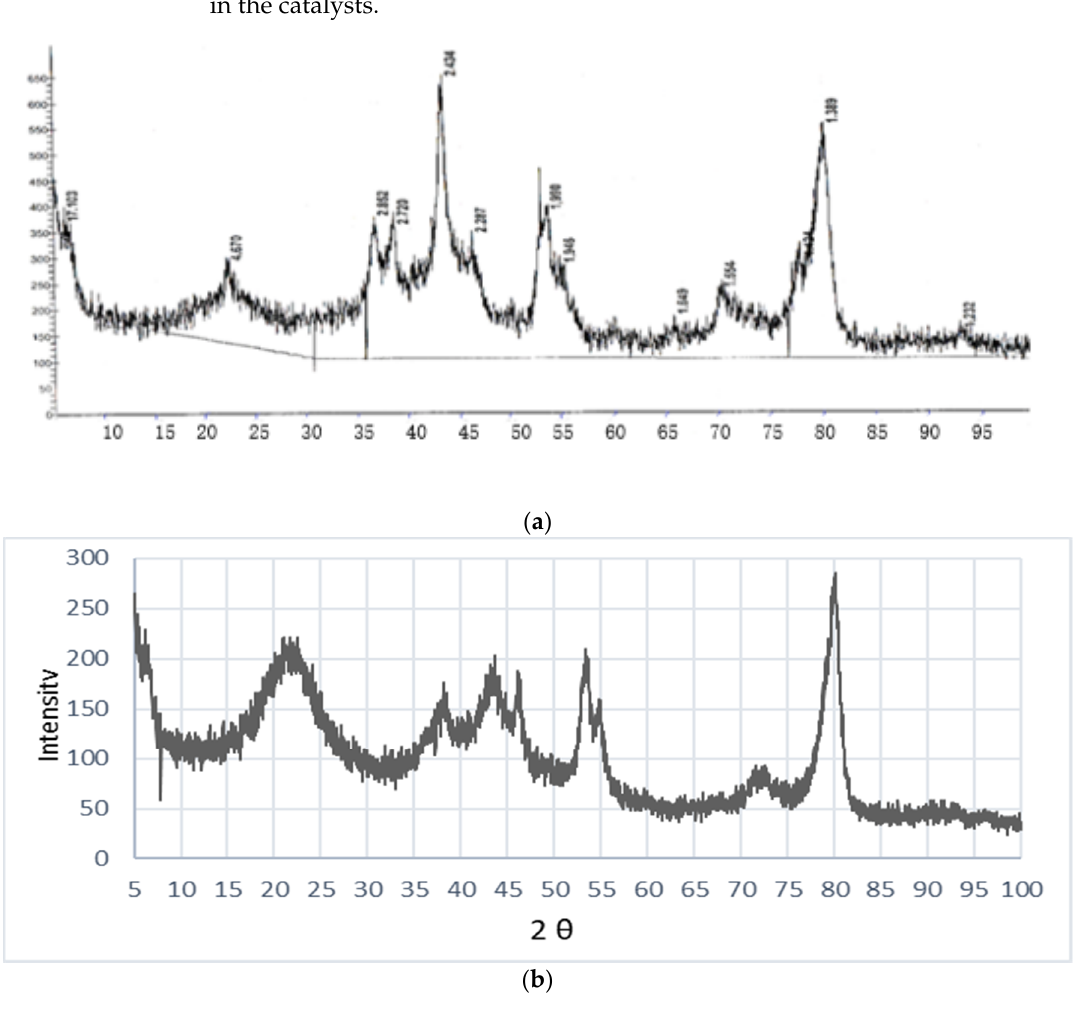
Figure 1. XRD pattern of the 5%Co-Rh(98:2)/Al 2 O 3 ( a ) and γ-Al 2 O 3 ( b ) used as a support. The TEM study of a ‘fresh’ (preliminary reduced by H 2 , 300 °C and then passivated in Ar flow) sample of the 5%Co-Rh(9:1)/Al 2 O 3 catalyst showed the highly dispersed and uniformly distributed spherical particles with the average size of 1.5–2 nm, microdiffraction analysis of which revealed the existence of metallic states both of Rh 0 and Co 0 (Figure 2a).